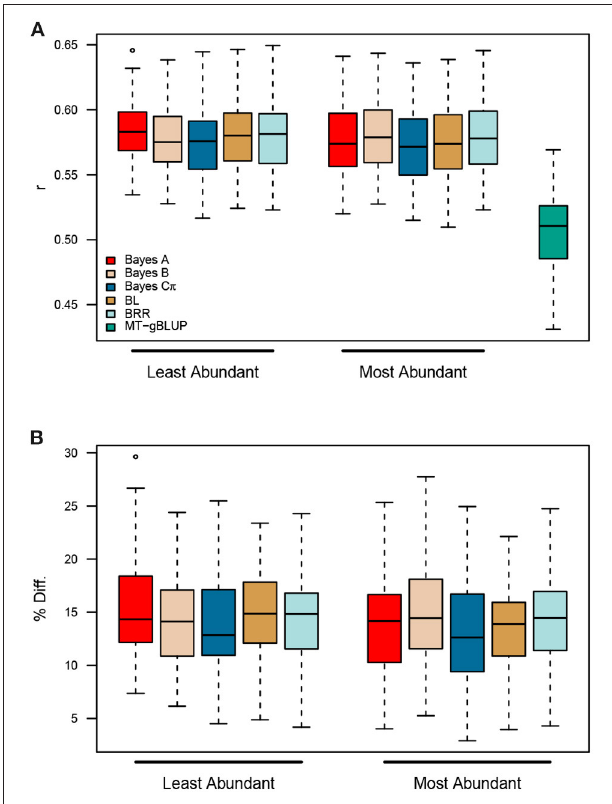
FIGURE 5 | Prediction accuracies for two multi-kernel trait-specific BLUP models (MK-TGRM-BLUP) that use TGRM for the three most abundant and three least abundant fatty acids. Estimated marker effects for the most abundant fatty acids (C16:0, C18:1, and C18:2) were used to create the three TGRM and were used in a multi-kernel gBLUP framework to predict total lipid content. A similar approach was used with the three least abundant fatty acids (C14:0, C16:1, and C20:0). Predictions for each MK-TGRM-BLUP approach were compared to a multi-trait gBLUP approach. Five-fold cross validation was performed using 50 resampling runs. BL, Bayesian LASSO; BRR, Bayesian ridge regression; r , Pearson’s correlation